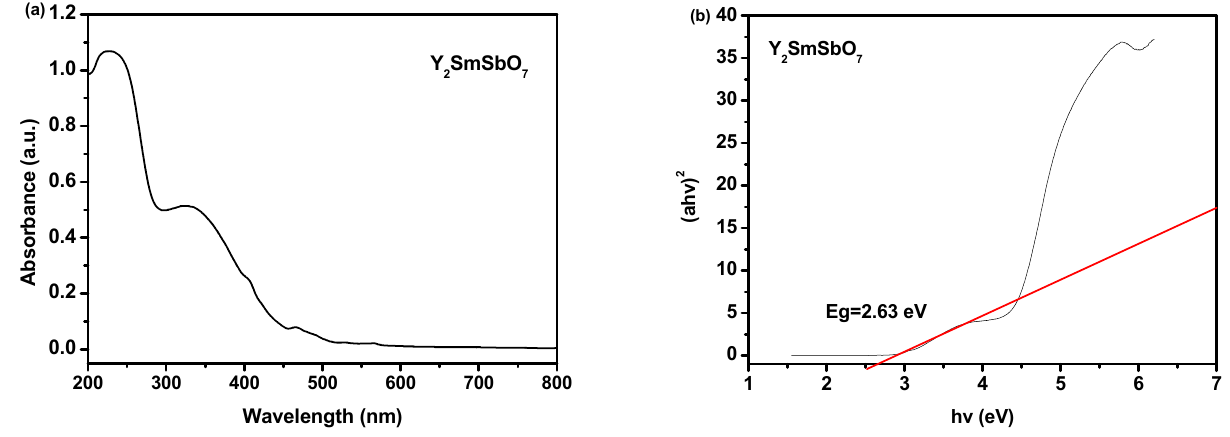
Figure 4. ( a ) UV − Vis diffuse reflectance spectra of Y 2 SmSbO 7 ; ( b ) plot of ( α h ν ) 2 versus h ν for Y 2 SmSbO 7